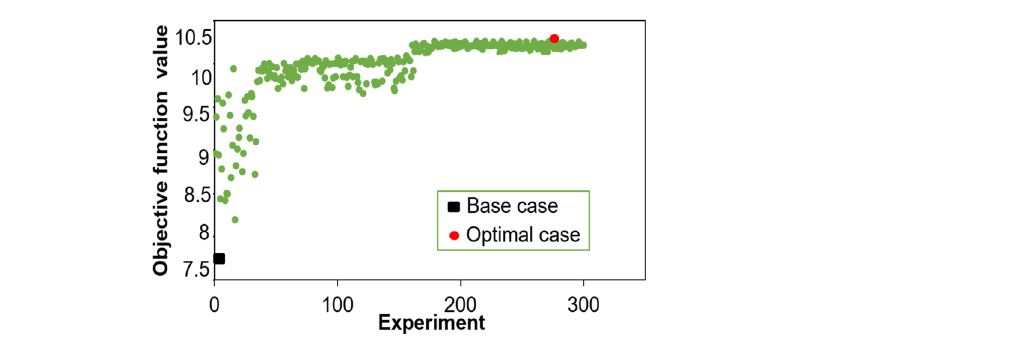
Figure 9. Value of objective function for optimization